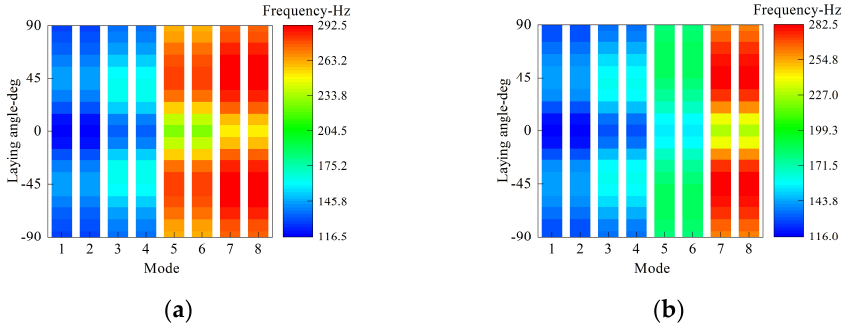
Figure 9. The first eight frequency values with respect to thickness and laminated scheme of the middle annular plate. ( a ) Clamped boundary. ( b ) Free boundary. middle annular plate. ( a ) Clamped boundary. ( b ) Free